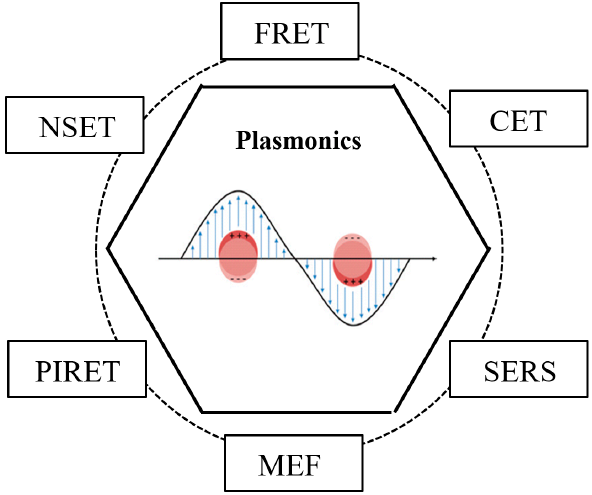
Figure 46. The main resonance energy transfer process involving plasmonic noble NPs.